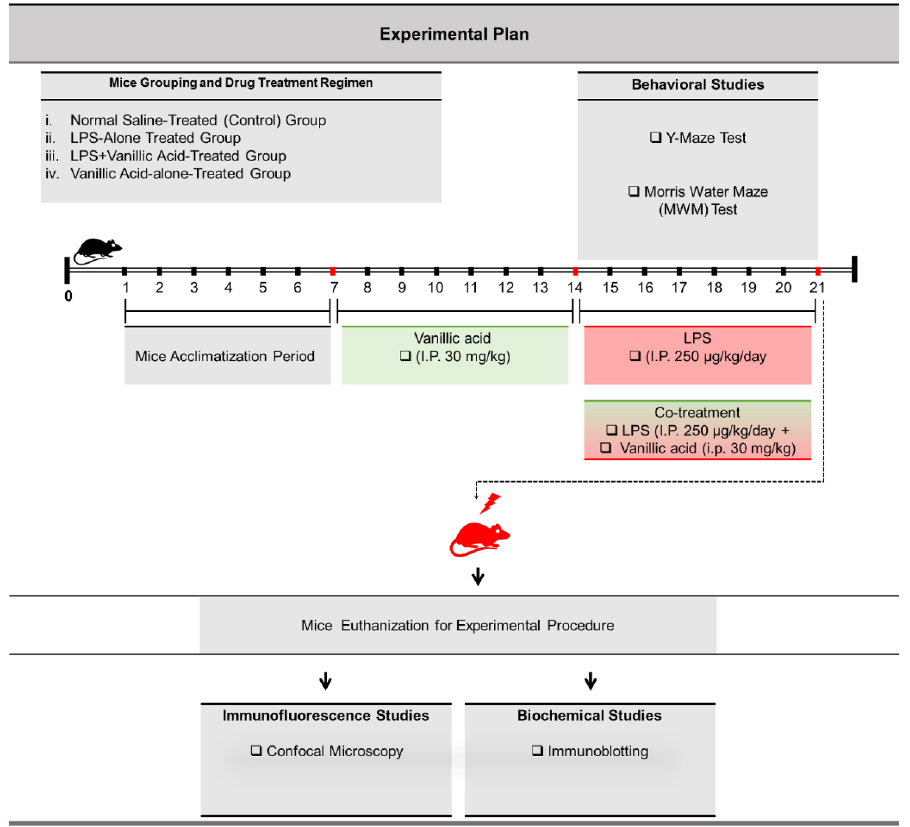
Figure 7. Schematic design of the current research study, classification of animals into the experimental grouping, drug dosage treatment, behavioral analyses, biochemical and morphological experimental approach for the entire research study. The experimental mice were randomly divided into four groups. (i) mice treated with normal-saline as a vehicle (two weeks; I.P.); normal saline-treated (Cont.) group. (ii) mice treated with vehicle (one week) and LPS (I.P.: 0.25 mg/kg/day; one week); LPS-alone treated group. (iii) mice treated with LPS (0.25 mg/kg/day; one week) and V.A (I.P.: 30 mg/kg/day; two weeks); i.e., one week before the LPS treatment and one week co-treated with LPS); V.A+LPS co-treatment group. (iv) mice treated with V.A (I.P.: 30 mg/kg/day; two weeks); V.A-alone treatment group. After completion of behavioral analyses, experimental mice were euthanized and further subjected to immunoblotting and immunofluorescence analyses.